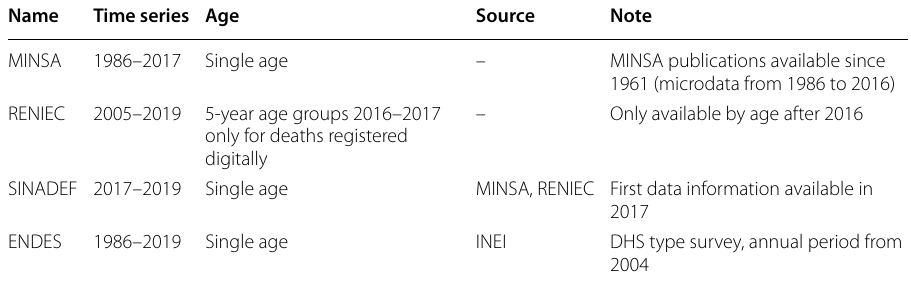
Table 1 Official data sources for mortality information and disaggregation characteristics,